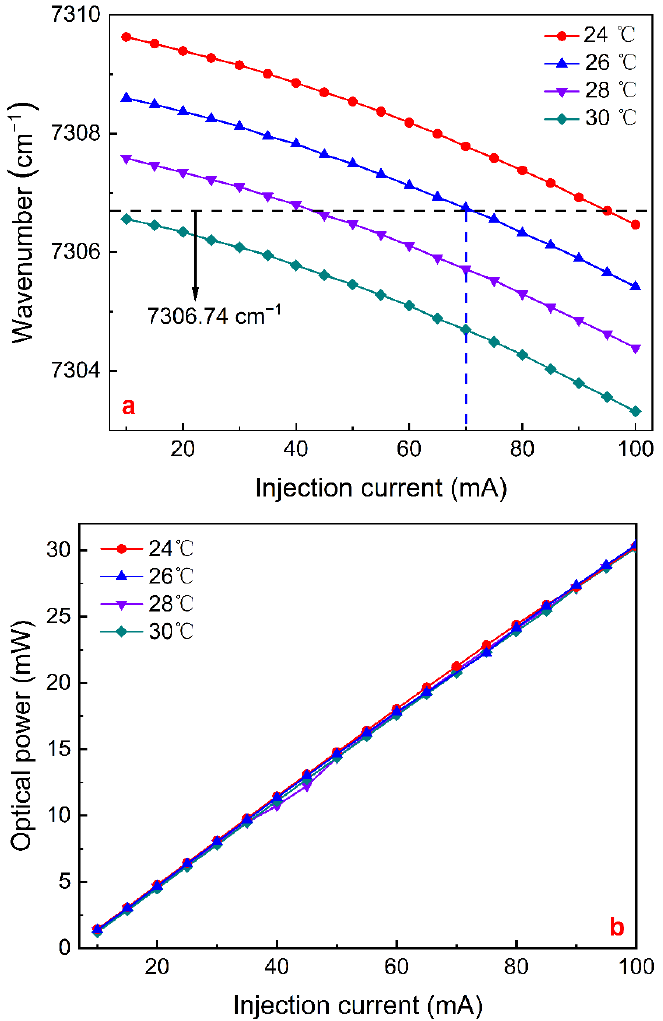
Figure 4. Output characteristics of the 1368.60 nm CW-DFB fiber-coupled diode laser: ( a ) output wavenumber as a function of injection current at four different temperatures; ( b ) optical output power as a function of injection current at four different temperatures.